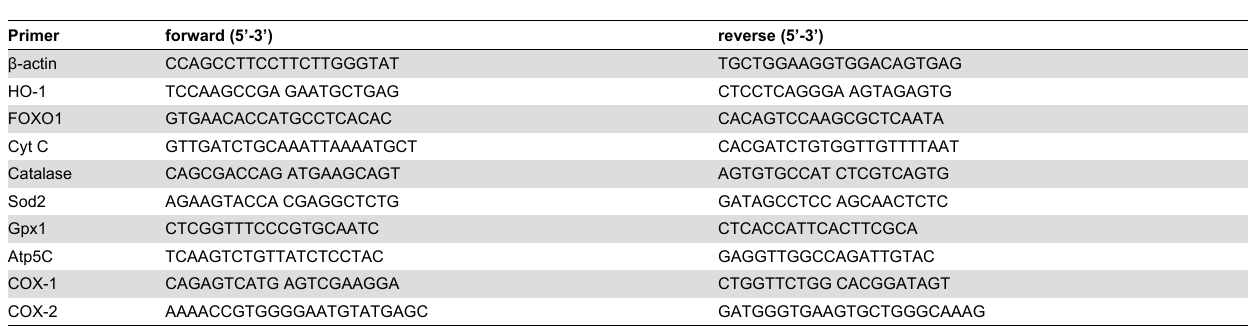
Table 1. The qPCR primers